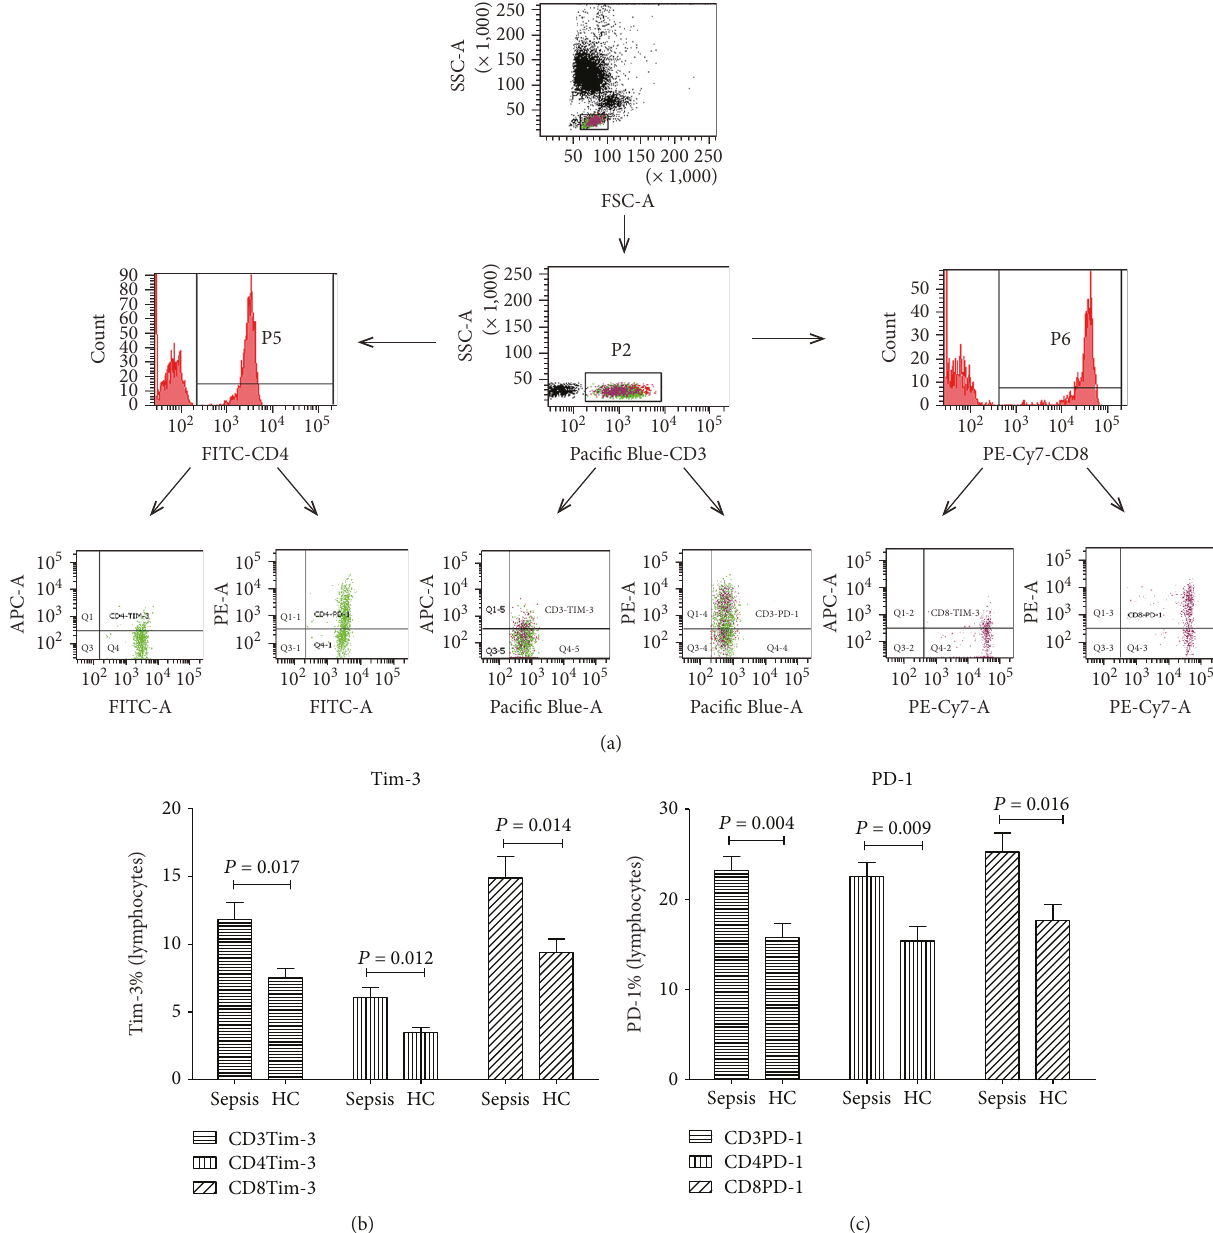
Figure 1: Tim-3 and PD-1 expression in 23 sepsis patients and 20 HC by fl ow cytometry. (a) Flow cytometry gating strategy for the determination of Tim-3(+) and PD-1(+) on T cells. (b) The percentages of CD3+Tim-3+, CD3+CD4+Tim-3+, and CD3+CD8+Tim-3+ T cells. (c) The percentages of CD3+PD-1+, CD3+CD4+PD-1+, and CD3+CD8+PD-1+ T cells. Statistical analysis was performed by the Mann – Whitney